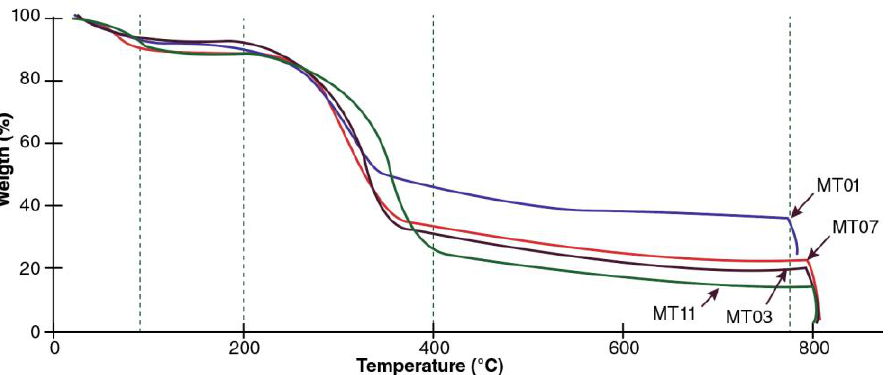
Figure 4. Fiber TGA test for five genotypes of M. textilis .